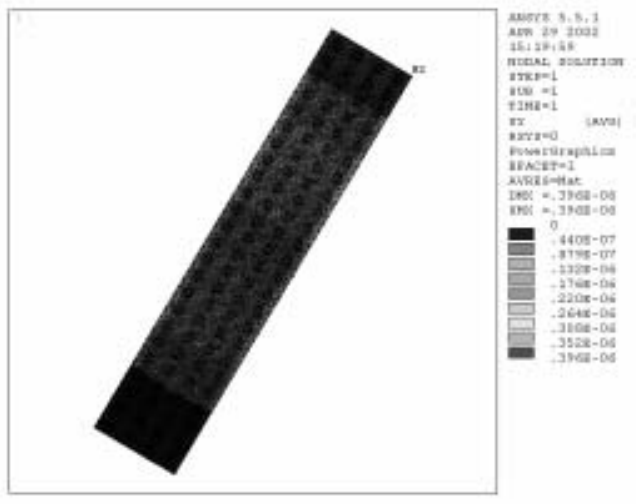
Fig. 18. Beam displacement under 1 N exciting